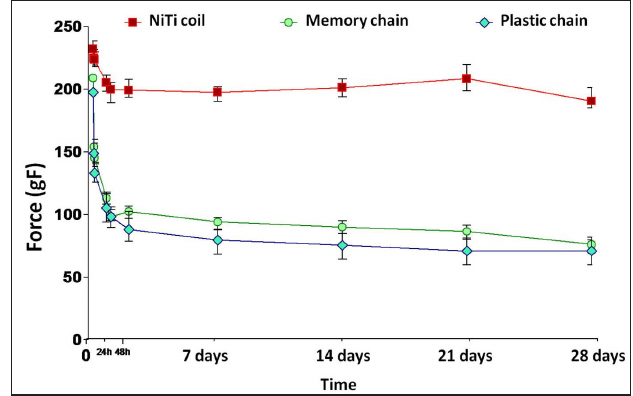
Fig. 2 - Force distribution (gF) of space closure materials over 28 days of